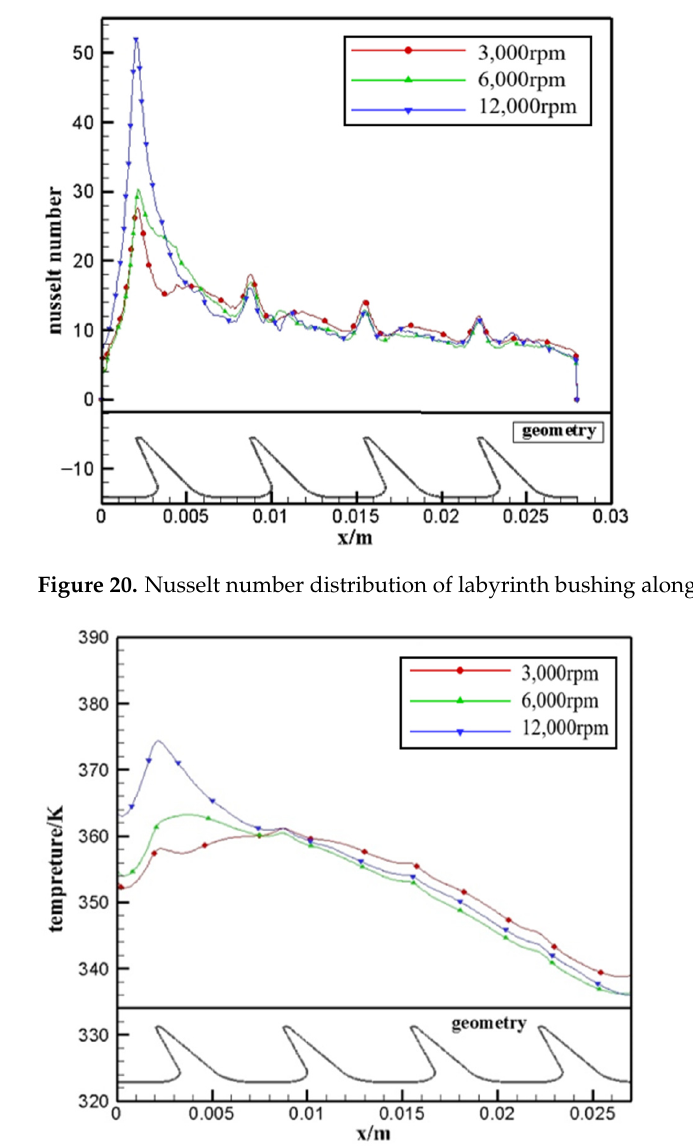
Figure 21. Temperature distribution of labyrinth bushing along the path.